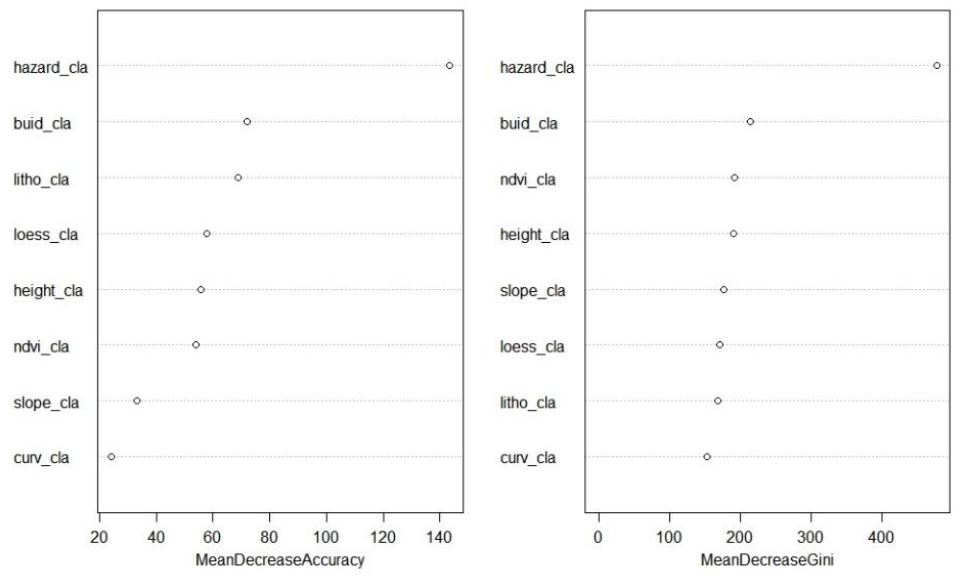
Figure 8. Mean decrease accuracy and mean decrease Gini of variables assigned by the random classifier. The vertical axis is the inducing factor variable. hazard—hazard density; build—build forest classifier. The vertical axis is the inducing factor variable. hazard — hazard density; build — density; lithe—thickness of exposed bedrock; loess—loess thickness; height—relief; ndvi—NDVI; build density; lithe — thickness of exposed bedrock; loess — loess thickness; height — relief; ndvi — curv—profile NDVI; curv — profile curvature.